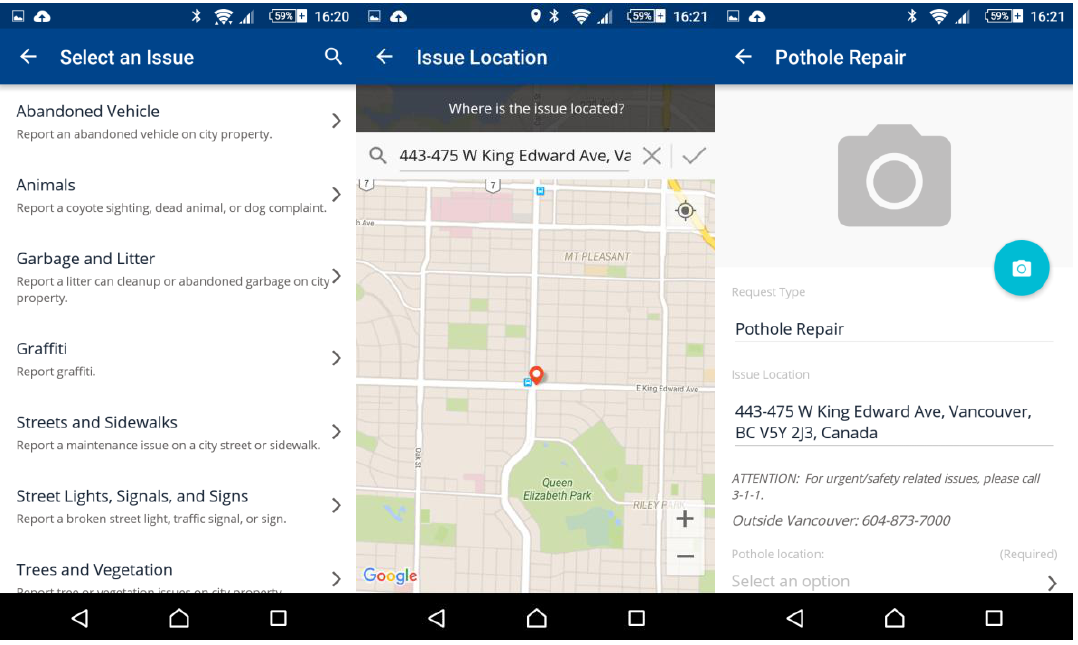
Figure 3. VanConnect